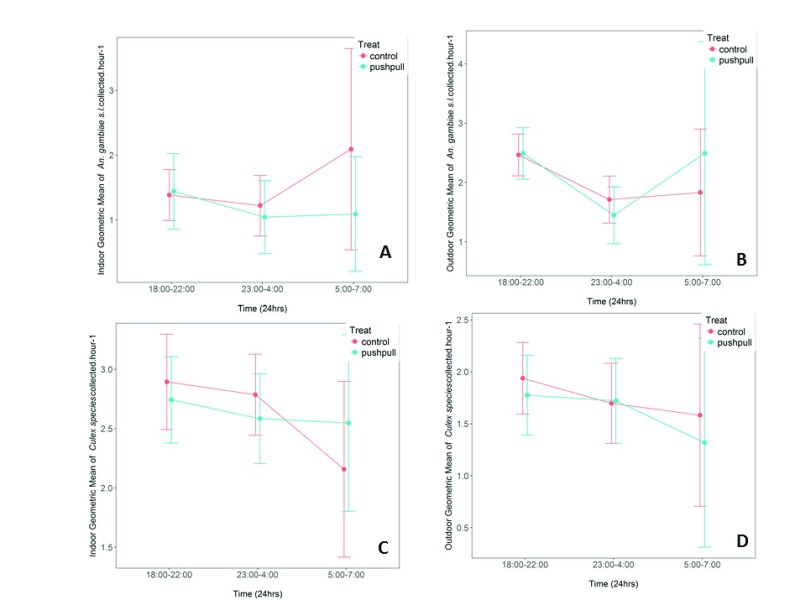
Cumulative geometric mean number of host-seeking malaria vectors and non-malaria vectors caught indoors and outdoors.(
A &
B) represent
An. gambiae; (
C &
D) represent
Culex species. The mosquitoes were caught during early night, midnight and early morning hours. Differences between treated and control houses are shown. Error bars represent 95% Confidence Intervals.